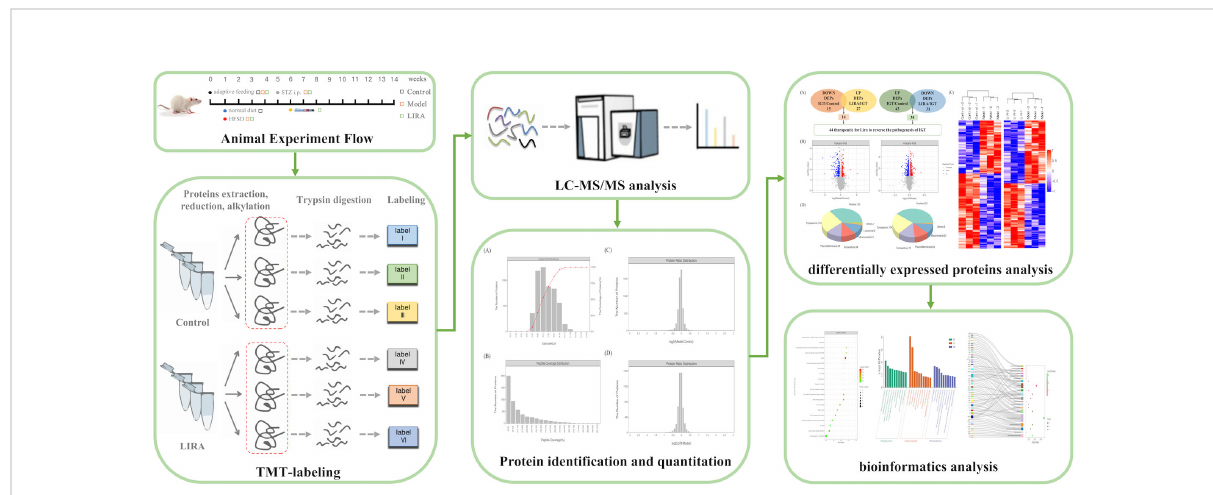
FIGURE 1 Flow chart of animal experiments. The diagram of TMT marker quantitative proteomics analysis operation mainly included steps such as protein extraction, peptide enzymatic hydrolysis, TMT labeling, chromatographic fractionation, liquid chromatography-tandem mass spectrometry (LC- MS/MS) data collection, data retrieval, GO and KEGG biological enrichment functional analysis, etc. LIRA, Liraglutide; STZ, StrepStozocin; ip, intraperitoneal injection; HFSD, high-fat and high-sugar